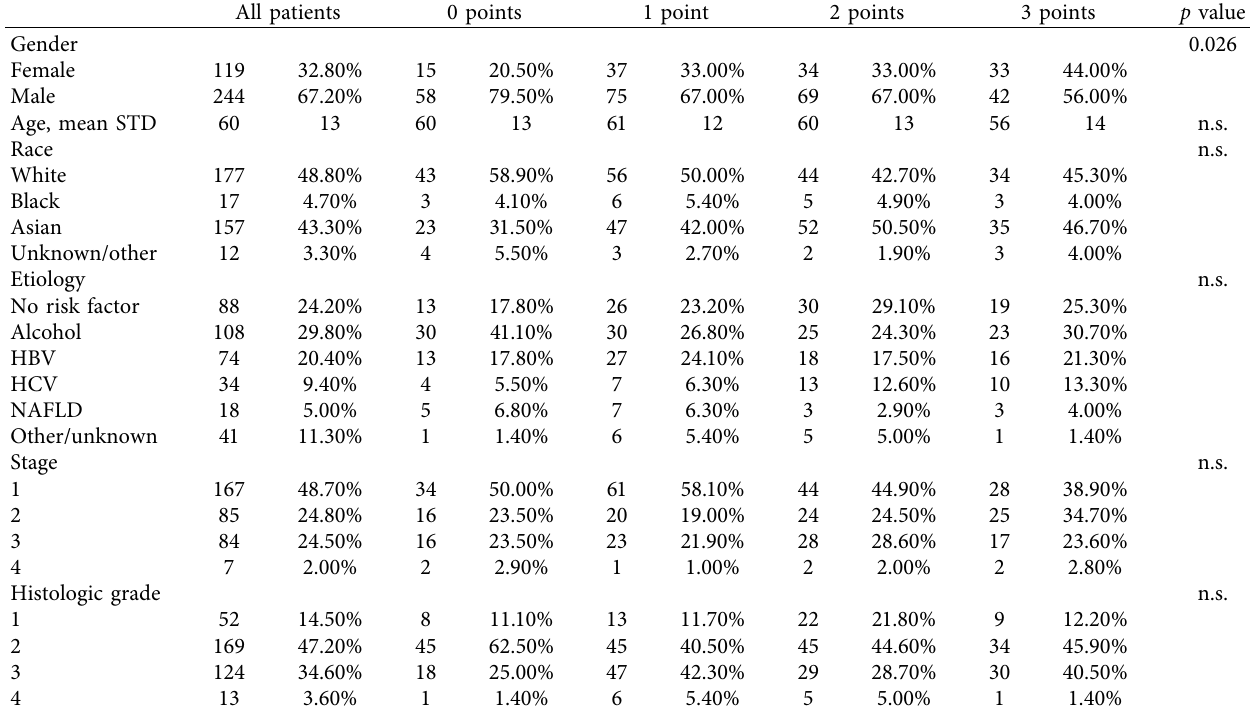
Table 1: Comparison of demographics by risk score.